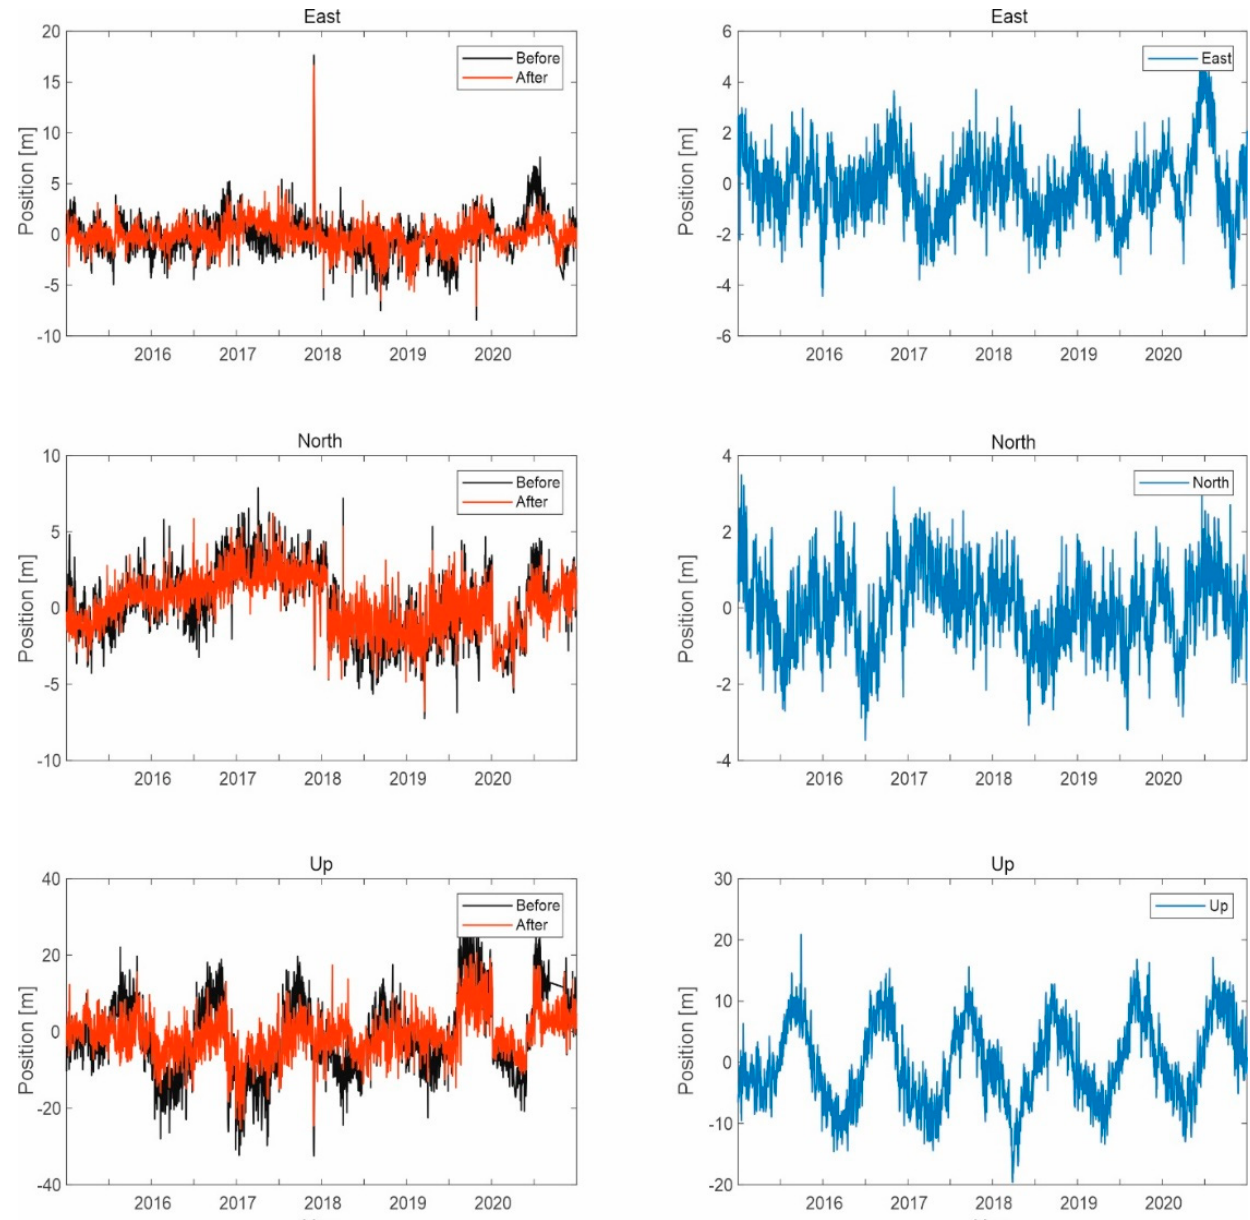
Figure 10. Signal processing in the GPS receiver working on the L1 frequency; on the left side, the signal waveform in color without the noise suppression system applied; on the right side, the working system operating in the LTE system signal elimination for the reception of signals from four satellites.